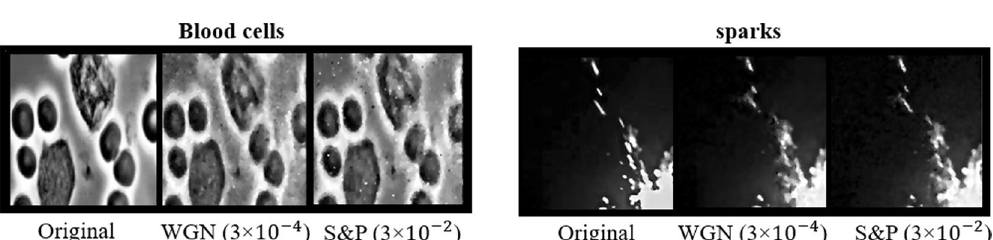
Figure 5. ( a ) Reconstructed frames, ( b ) SSIM and ( c ) MSE measurements of the immune cell dataset for the partially known encoder data at various known percentages of the true values with the unknown key values located at the central section of the encoder.